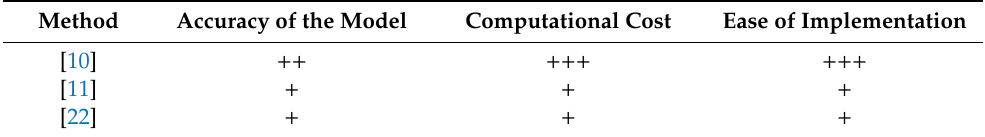
Table 3. Comparison between methods ( + worst, +++